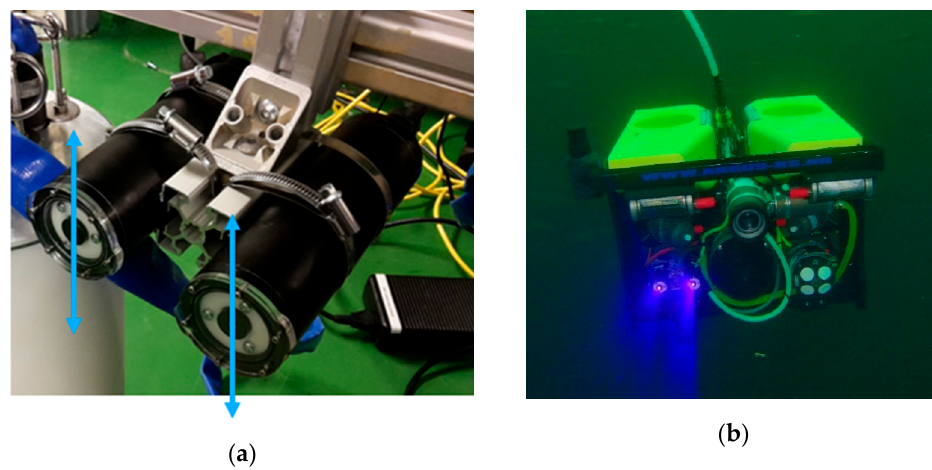
Figure 3. ( a ) The laser lines are mounted inside watertight tubes from Blue Robotics. The laser lines are perpendicular to the plane containing the two tubes and the camera. ( b ) The laser lines are mounted onto the ROV. The camera used is the on-board ROV camera, seen in the center of the ROV.